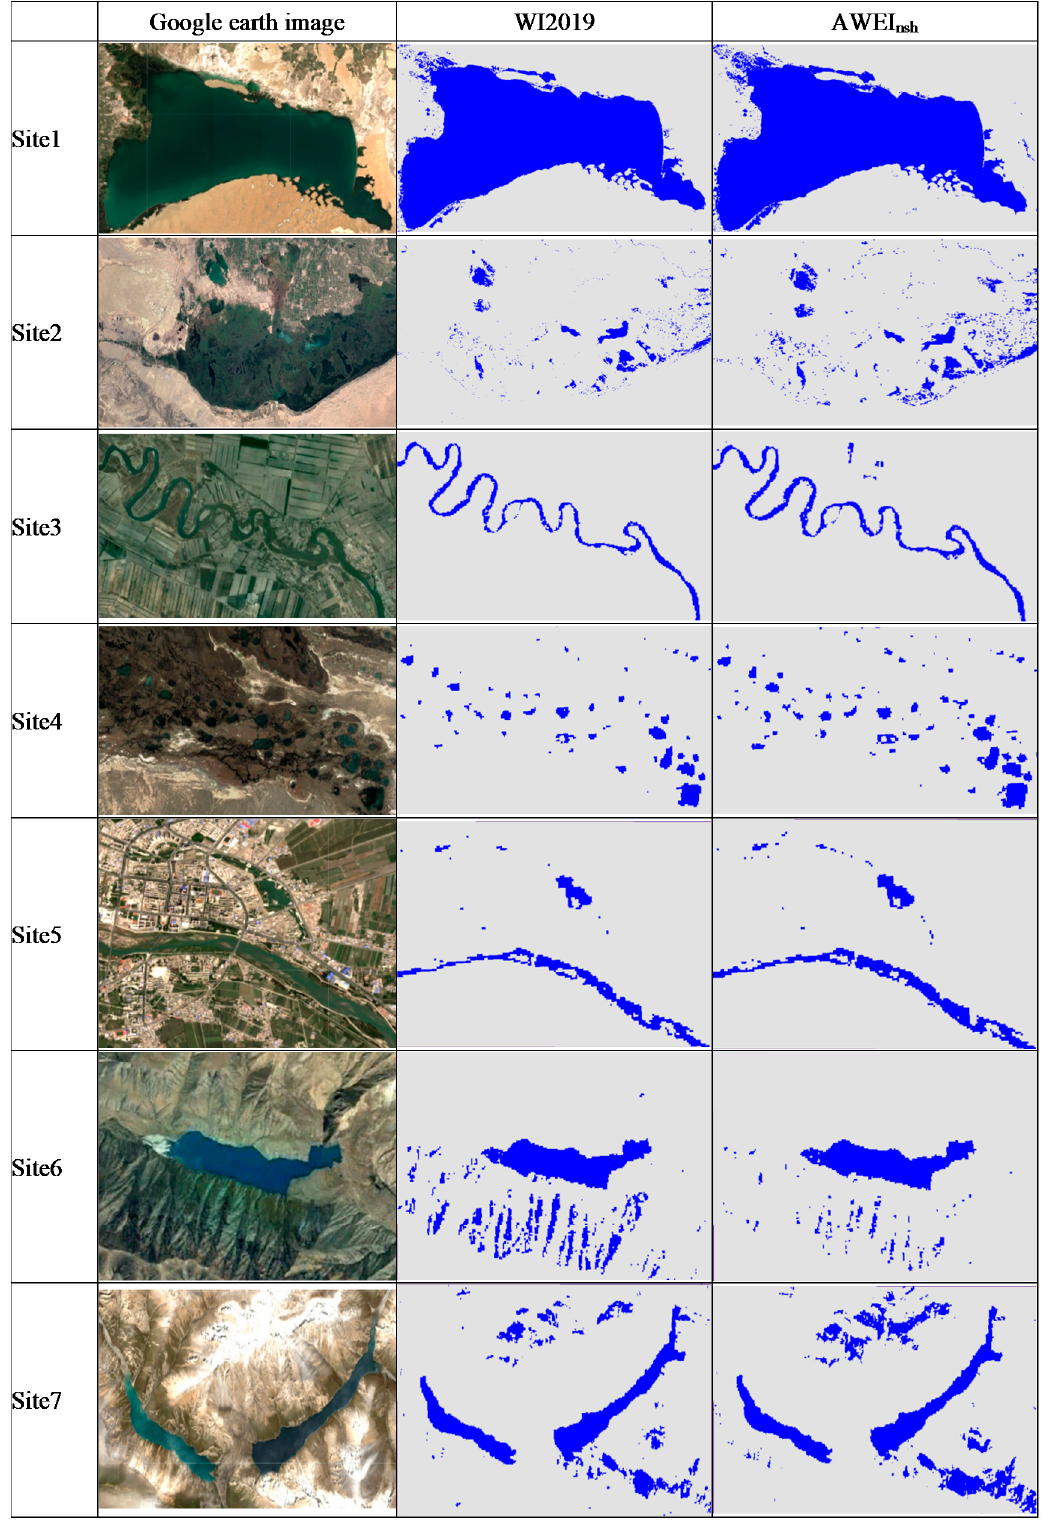
Figure 6. WI2019 and AWEI nsh surface water extraction details. 3.2. Changes of Extraction Accuracy under Water Index Threshold and Slope Iteration The slope mask is added on the basis of the optimization of water index